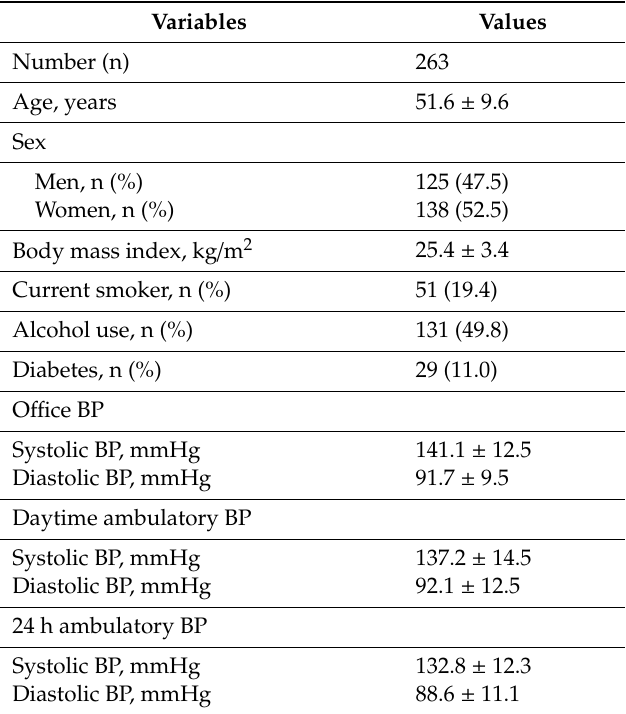
Table 1. Characteristics of study